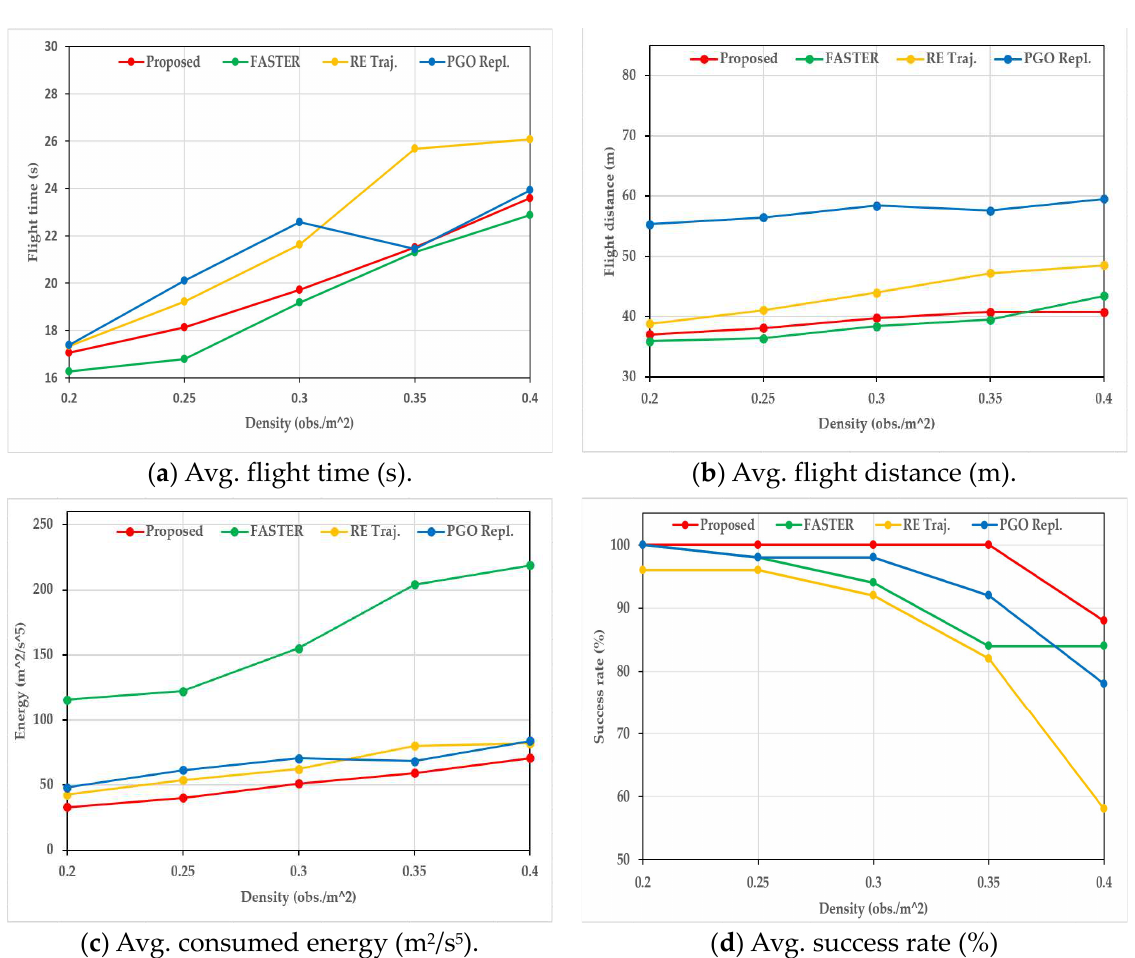
Figure 9. Results of the comparisons between the proposed method and FASTER, RET, PGO in different obstacle densities.